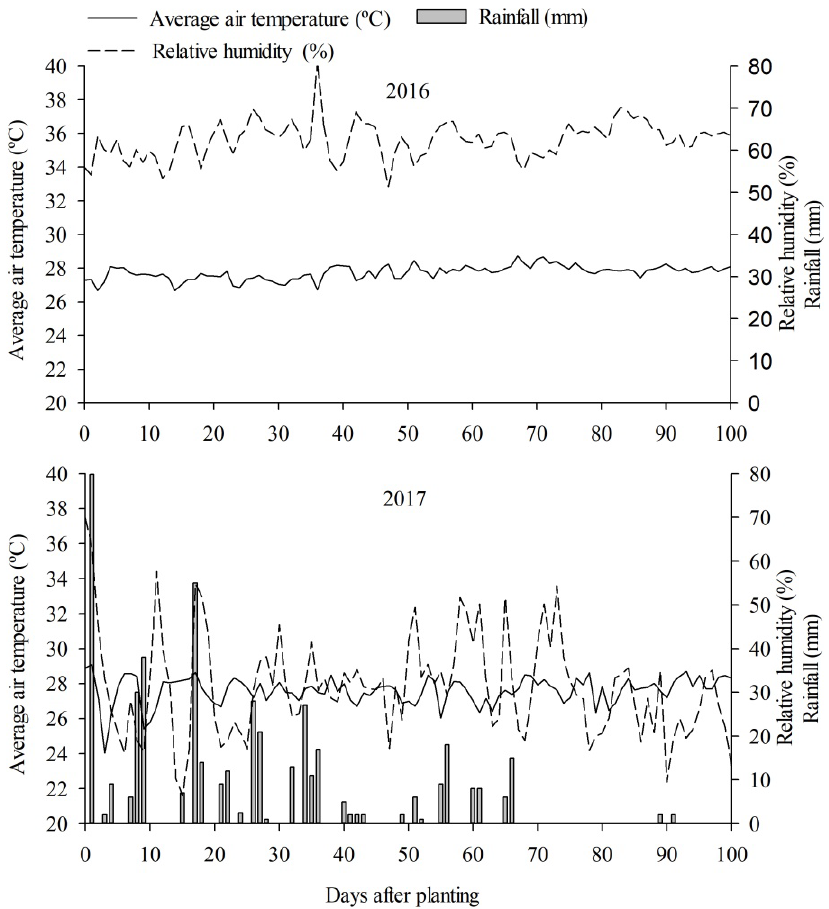
Figure 1. Average values of temperatures (°C), relative humidity (%), and precipitation (mm) in the two agricultural crops of sunflower. Source: INMET Automatic Meteorological Station and Rain Gauge from the Rafael Fernandes Experimental Farm (UFERSA).